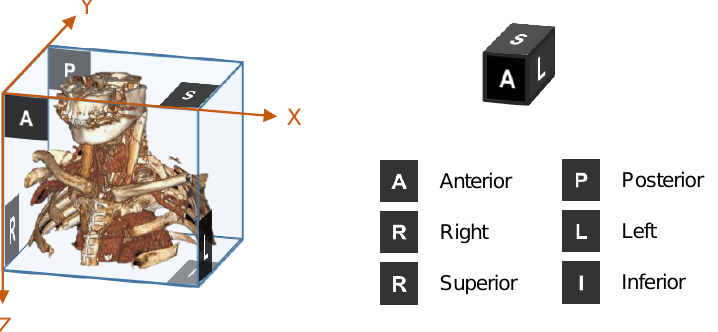
Figure 2. Cartesian axes directions in neck CT volume. On the left, volume rendering of a neck CT using RadiAnt Dicom Viewer (http://www.radiantviewer.com (accessed on 15 December 2022)) is shown with axes